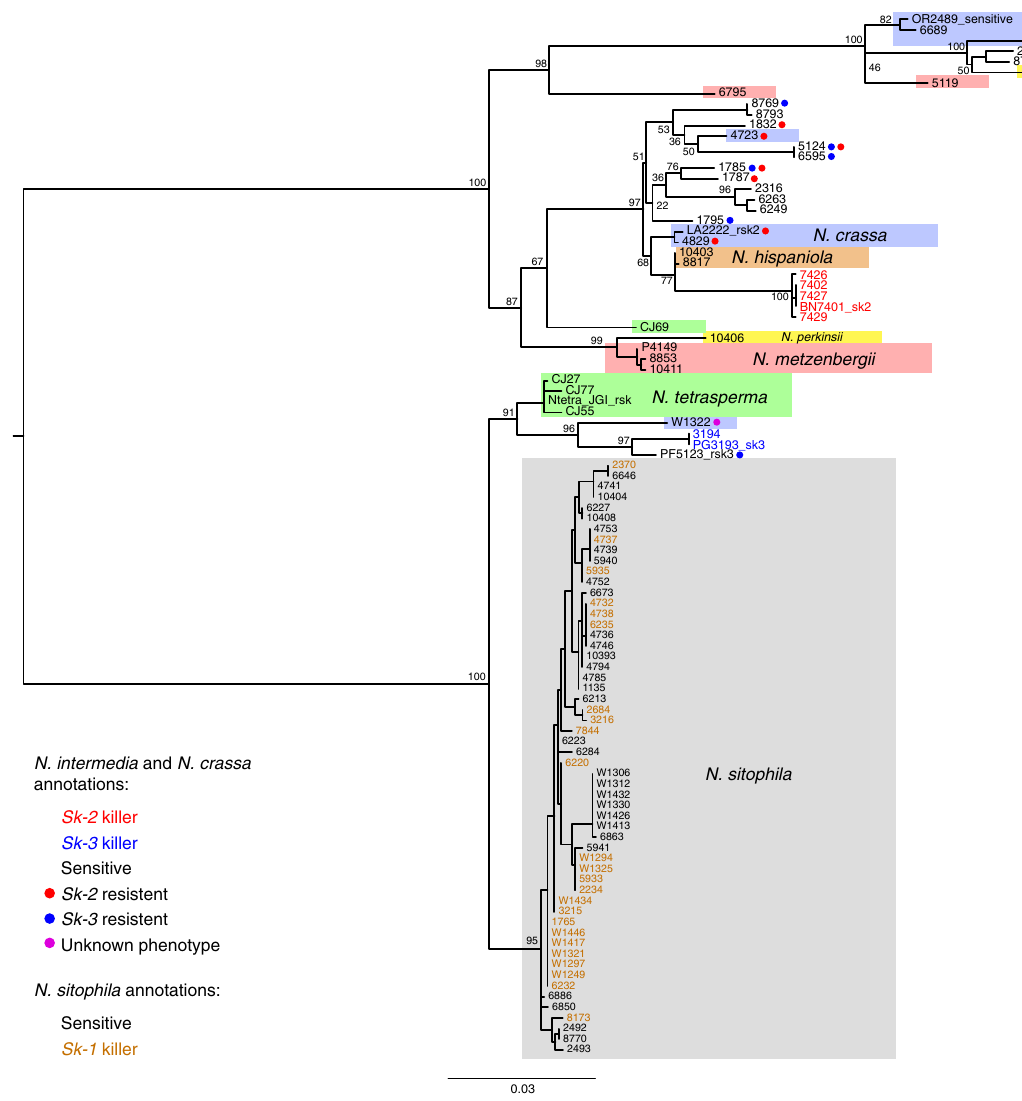
Fig. 5 Maximum likelihood phylogeny of the resistance locus rsk . The alleles are split into two major groups, with Sk-2 (marked with red text) in one and Sk- 3 (blue text) in the other. Sk-2 -resistant strains (marked with red dots) cluster with Sk-2 , but Sk-3 -resistant strains (blue dots) are found in both groups. All Neurospora sitophila strains have similar alleles at the rsk locus, and there is no clustering depending on whether they are Sk-1 killers (orange text) or sensitives (black text). Most N. intermedia and N. crassa strains have been tested for resistance against Sk-2 and Sk-3 , but this is not possible in most other Neurospora species, due to poor sexual compatibility. An exception is N. metzenbergii , where spore killing is observed in crosses with included